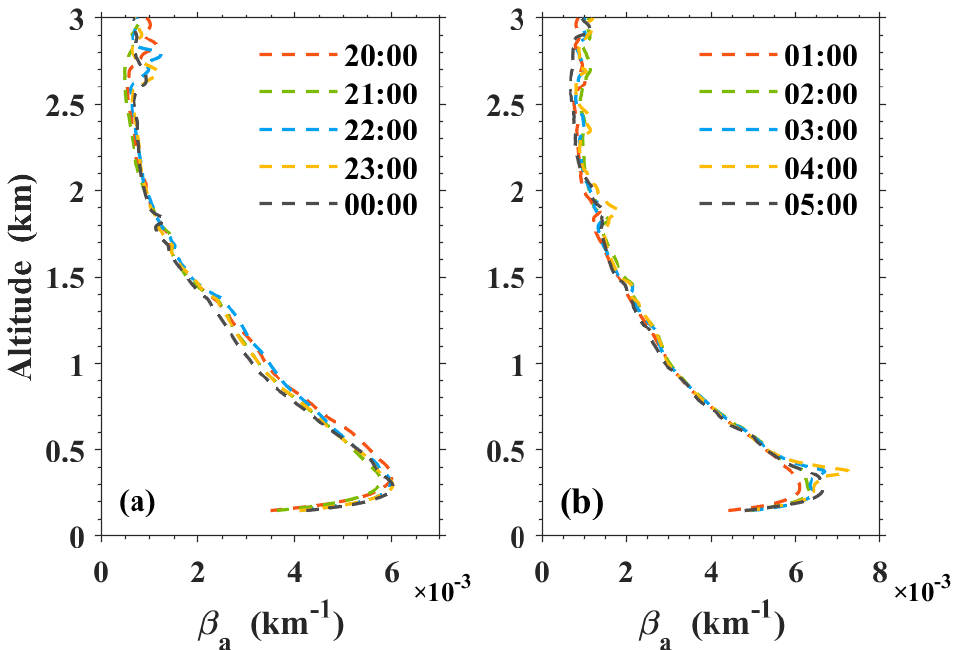
Figure 2. Hourly mean profiles of backscattering coefficients at nighttime from January 2017 to December 2019. Hourly backscattering coefficients profiles from ( a ) 20:00 to 00:00 LT and from ( b ) 01:00 to 05:00